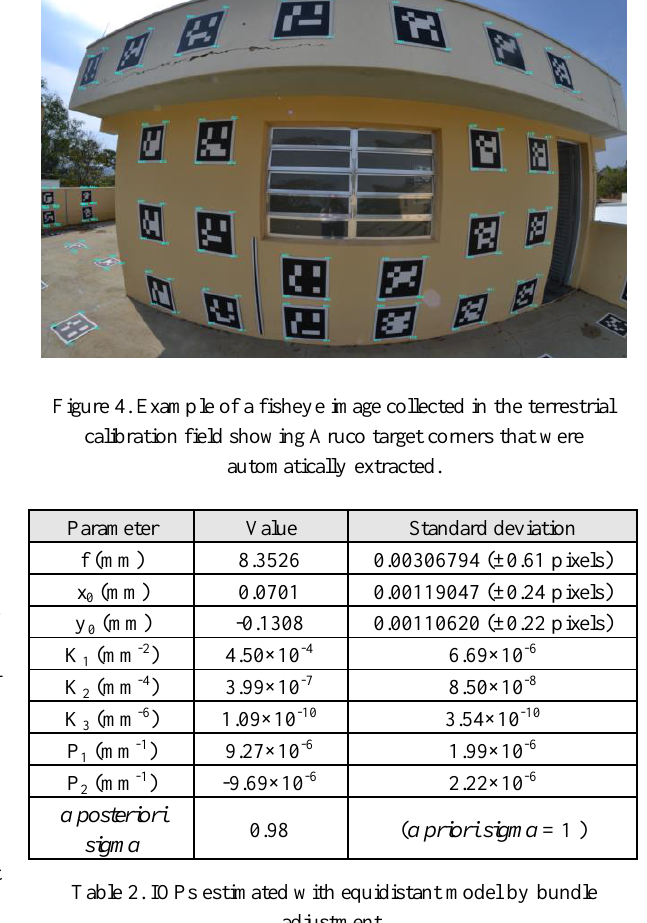
Table 2. IOPs estimated with equidistant model by bundle